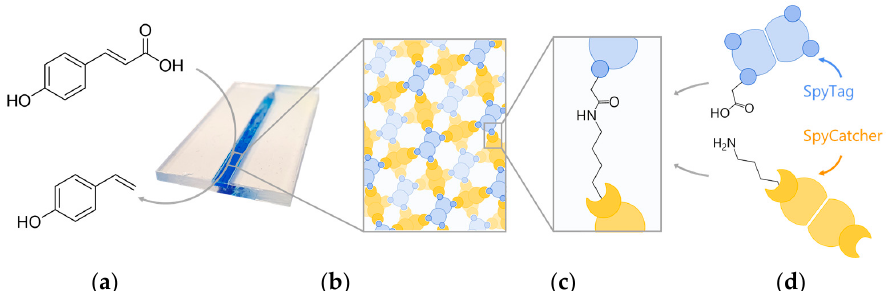
Figure 1. ( a ) Continuous synthesis of substituted styrenes from readily available bio ‐ derived phenolic acids through biocatalytic decarboxylation, as exemplified here for p ‐ hydroxystyrene, is achieved by implementation of a microreactor ( b ). This reactor is filled with an all ‐ enzyme hydrogel ( c ) comprised of the dimeric Phenolic Acid Decarboxylase (PAD), crosslinked via isopeptide bonds spontaneously generated through genetically fused SpyTag/SpyCatcher complexes ( d ). Note that the protein hydrogel loaded into the micro reactor ( b ) is stained with coomassie brilliant blue.